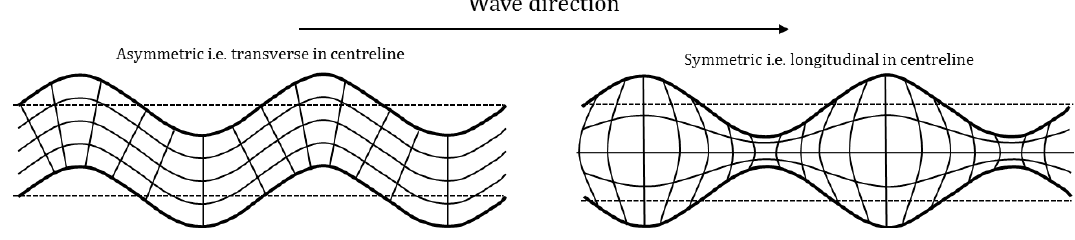
Figure 1. A diagrammatic representation of symmetrical and antisymmetric wave modes.